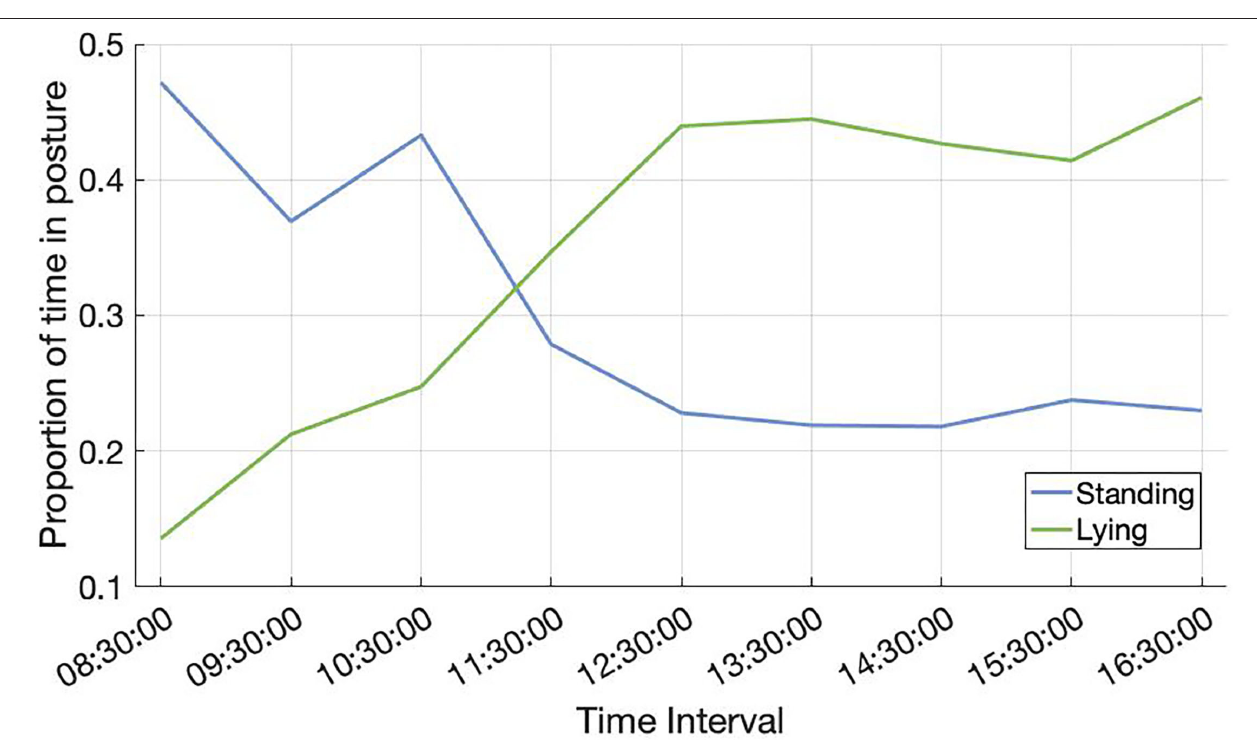
be around 25 ◦ C for growing-finishing pigs (Le Dividich et al., 1998; Renaudeau et al., 2008). However, this threshold may vary between breeds. Renaudeau et al. (2007) defined an